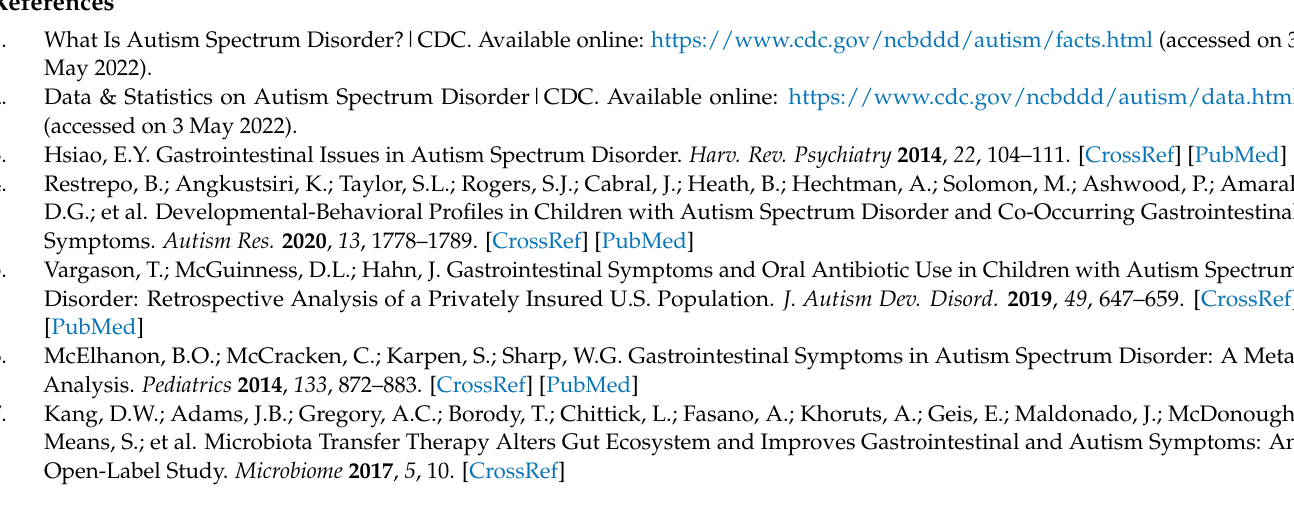
KOs comparison between groups; Table S4: Differences in number of taxa between groups; Table S5: Taxonomy and KOs comparison between TD and all ASD groups; Table S6: List of significantly different 37 KOs/metabolic pathways in ASD Baseline vs. TD children from Figure